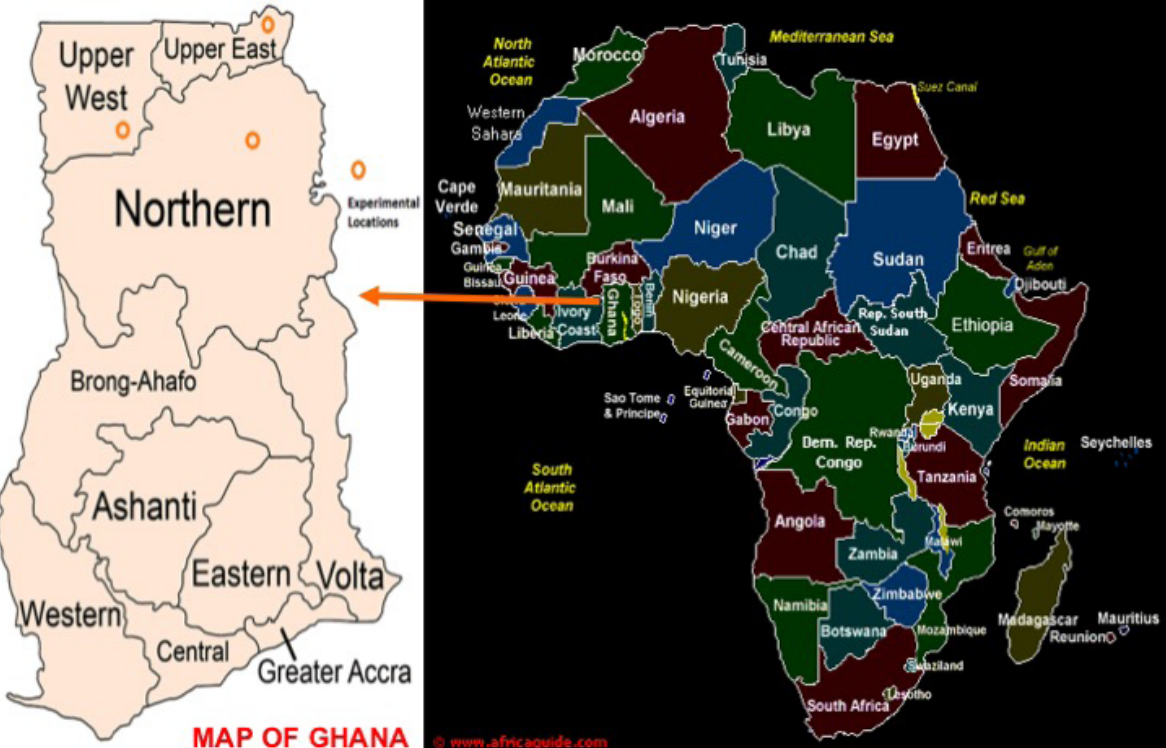
Figure 1: Map of the trials conducted in